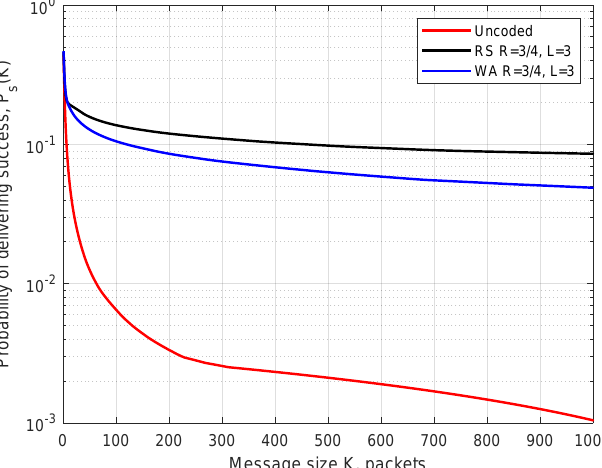
Figure 13. SDF for the production zone. Comparison of the WA and the RS codes of rate R = 3/4.